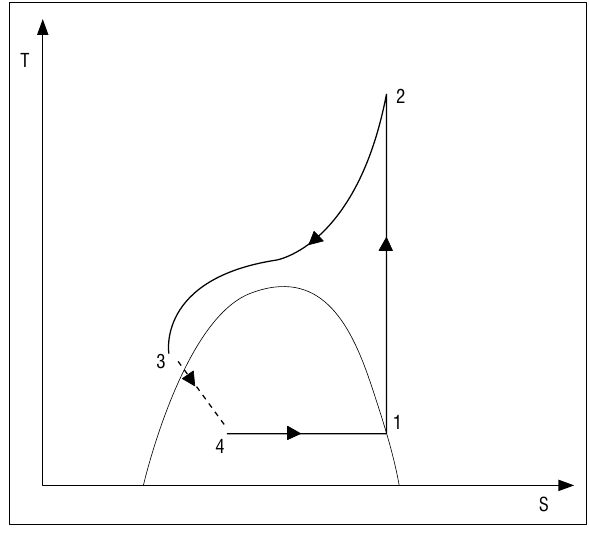
Figure 2: A theoretical transcritical cycle characterised by isentropic compression (process 1–2), isobaric heat output (process 2–3), isenthalpic expansion (process 3–4) and isobaric heat intake (process